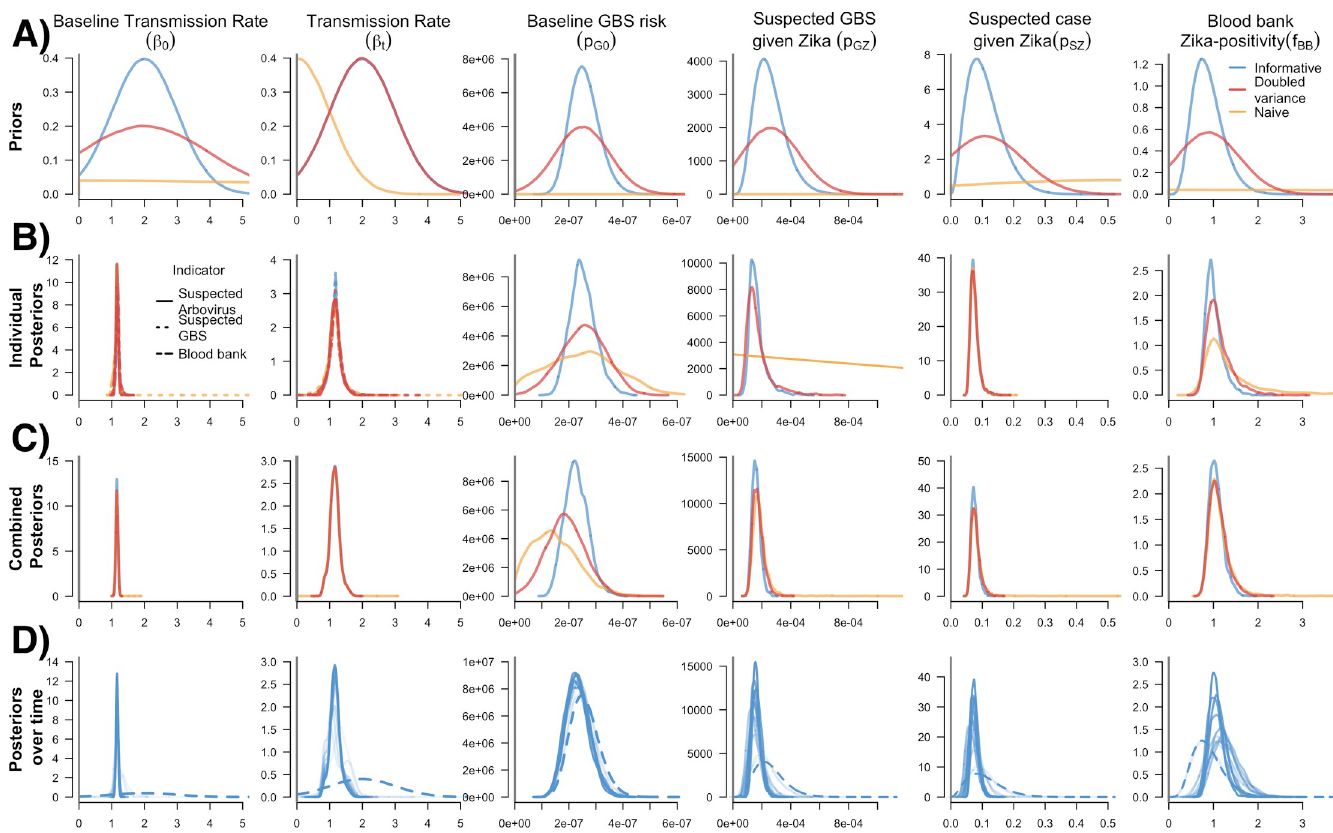
Fig 3. Prior and posterior parameter distributions from individual indicator models, the combined indicator model, and the combined model over time. A) Prior distributions of six model parameters. Color lines refer to assessed variance assumptions of prior distributions in sensitivity analyses. Final individual and combined indicator models used informative priors. B) Posterior distributions of model parameters from individual indicator models. The dashed lines for the Beta parameters refer to the posterior parameter distributions from three individual indicator models (suspected arbovirus cases, suspected GBS and blood bank). Separate plots of the beta parameters for each indicator model are available in Fig B in S1 Text. C) Posterior distributions of model parameters from the combined model. D) Posterior distributions over time (i.e., four-week increments from the end of January 2016 to the end of December 2016) from the combined model using informative priors. Dashed lines refer to the informative priors for each model parameter. Darker transparency of the lines refers to each the posterior distribution from each 4-week increment over time (i.e., the darkest lines coincide with 4-weeks increments further into the time-series).